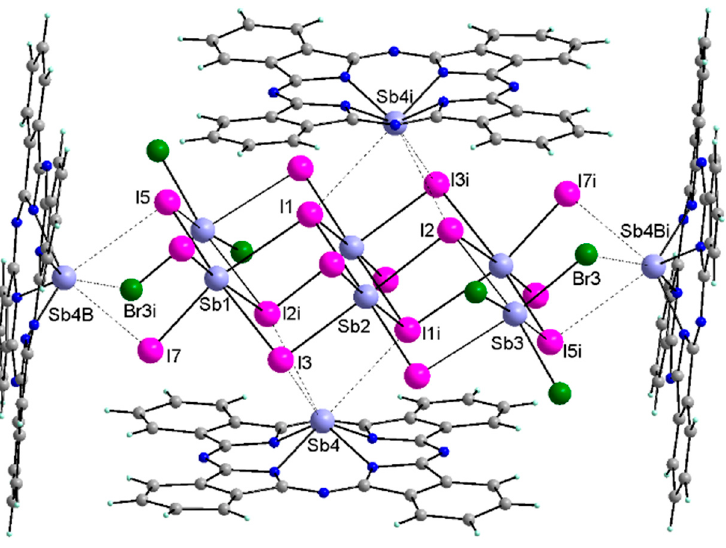
Figure 3. View of the anionic [Sb 6 I 16 Br 6 ] 4 − complex surrounded by four (SbPc) + in the crystal of 1 .